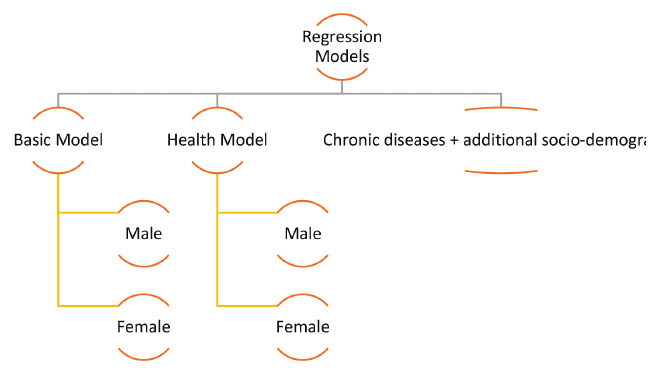
Figure 1. Three Models and Regression Models with